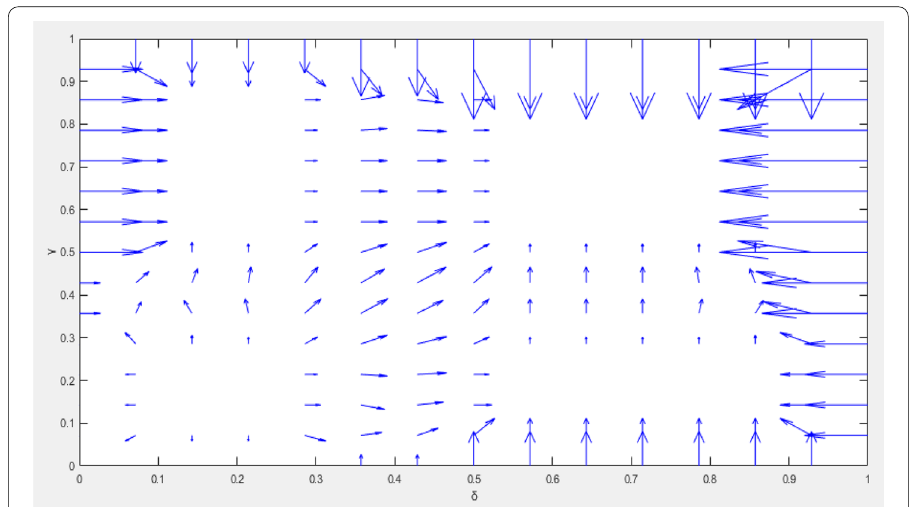
Fig. 10 Model dependency of δ and γ on the security risk